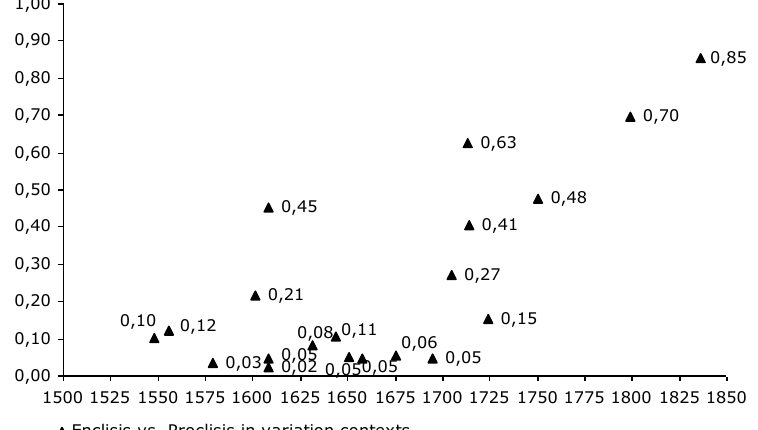
Figure 1 : Enclisis versus Proclisis in variation contexts I